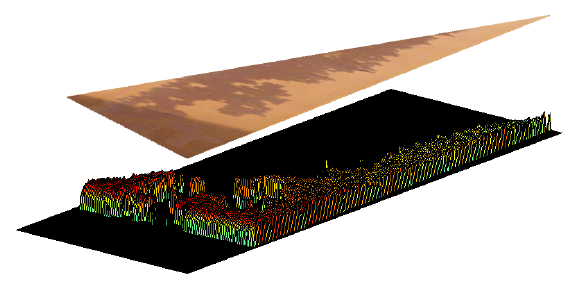
Figure 16. 3D view of image difference of test 3 limited to the right hump (bright points)